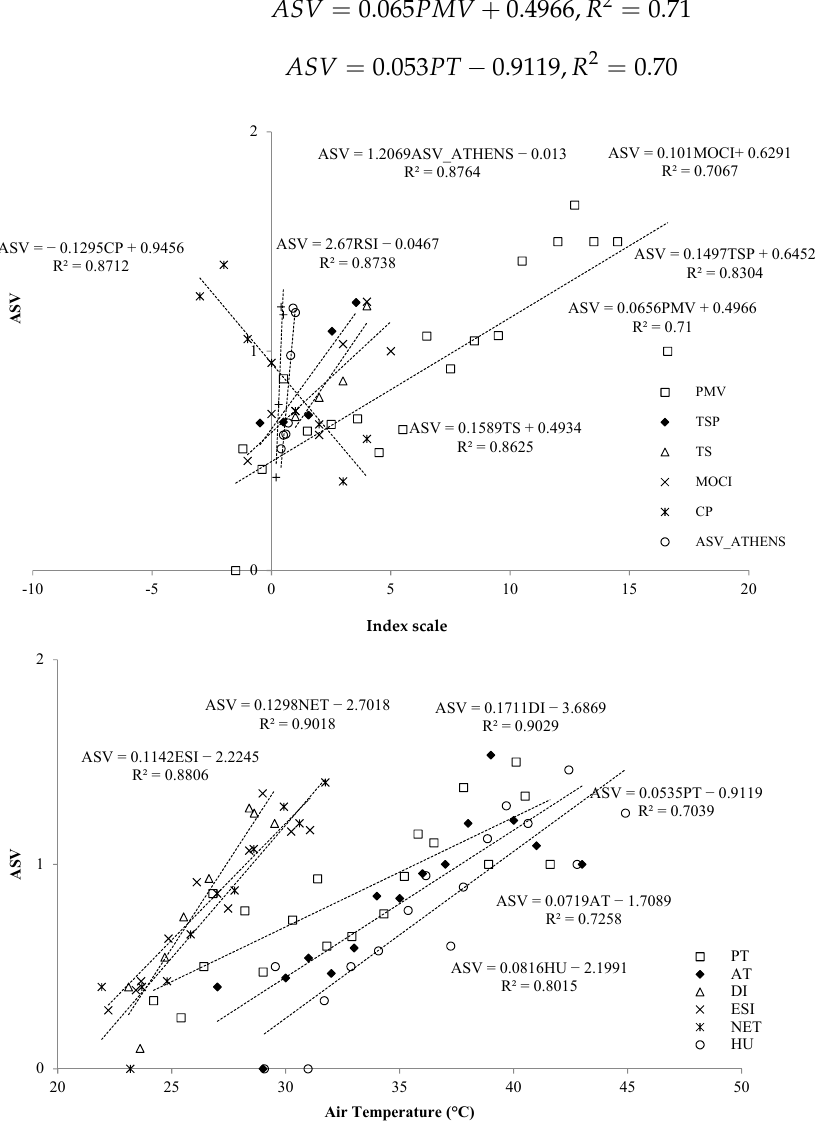
Figure 11. Correlation between the Actual Sensation Vote and Thermal indices.